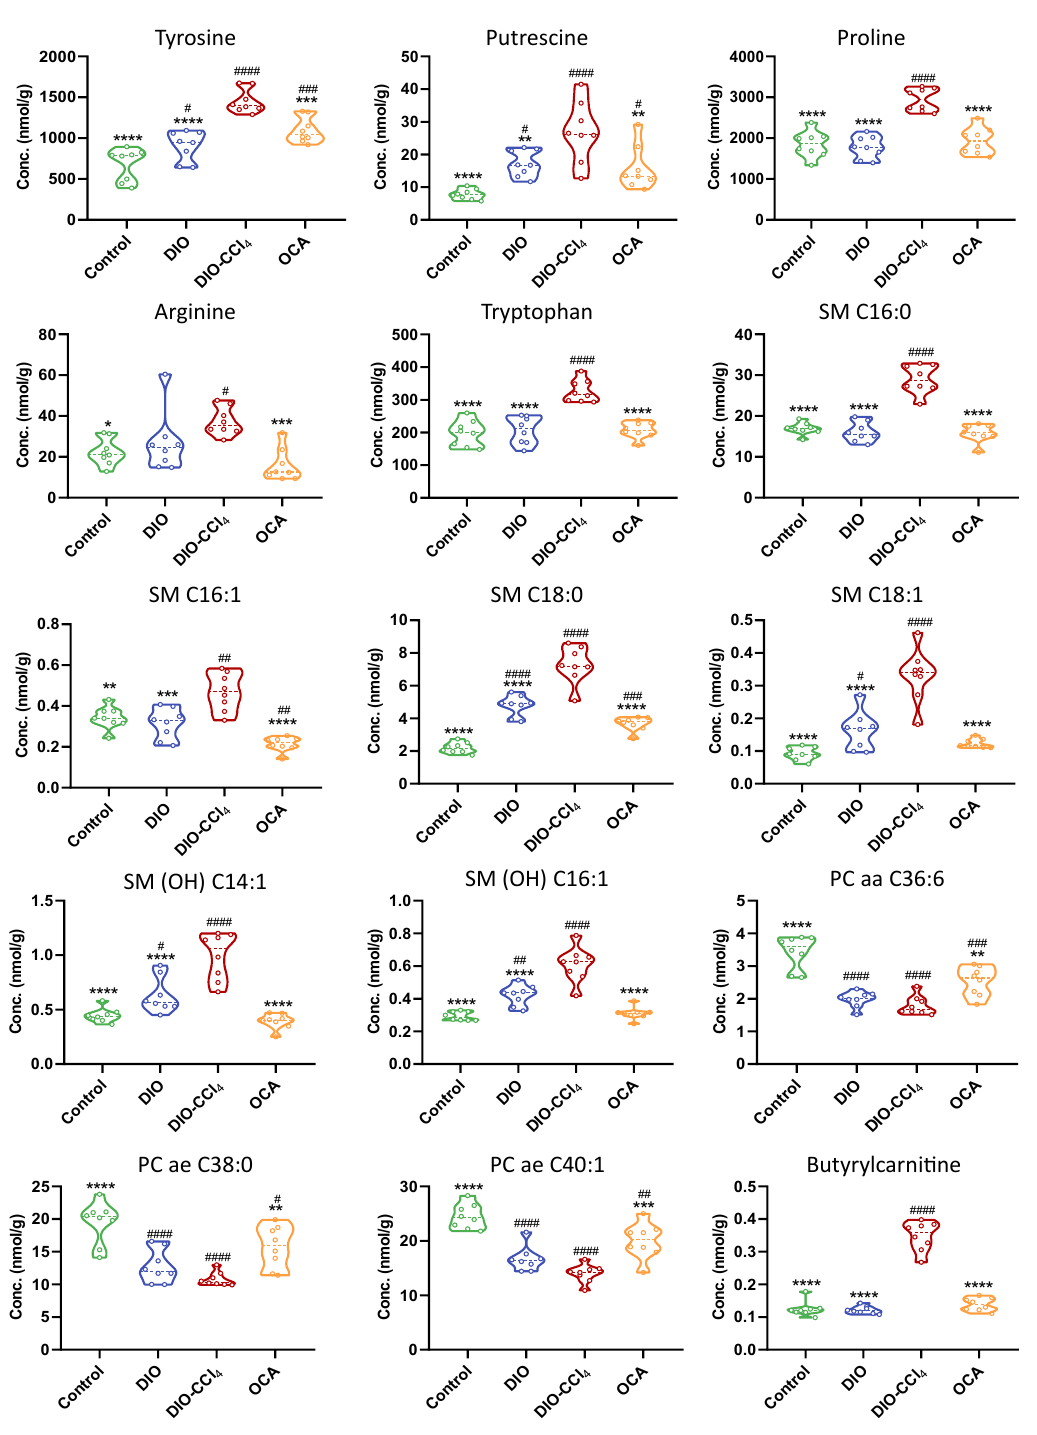
Figure 8. Violin plots of the differential metabolites of liver. * p < 0.05, ** p < 0.01, *** p < 0.005 and **** p < 0.001 vs. the DIO-CCl 4 group; # p < 0.05, ## p < 0.01, ### p < 0.005 and #### p < 0.001 vs. the Control